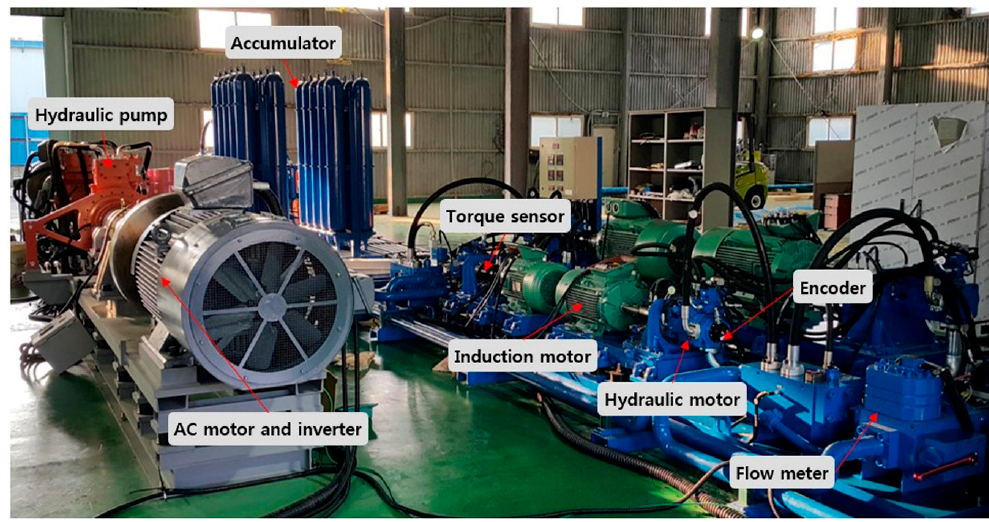
Figure 3. Development of a simulation environment of the wireline riser tensioning system.